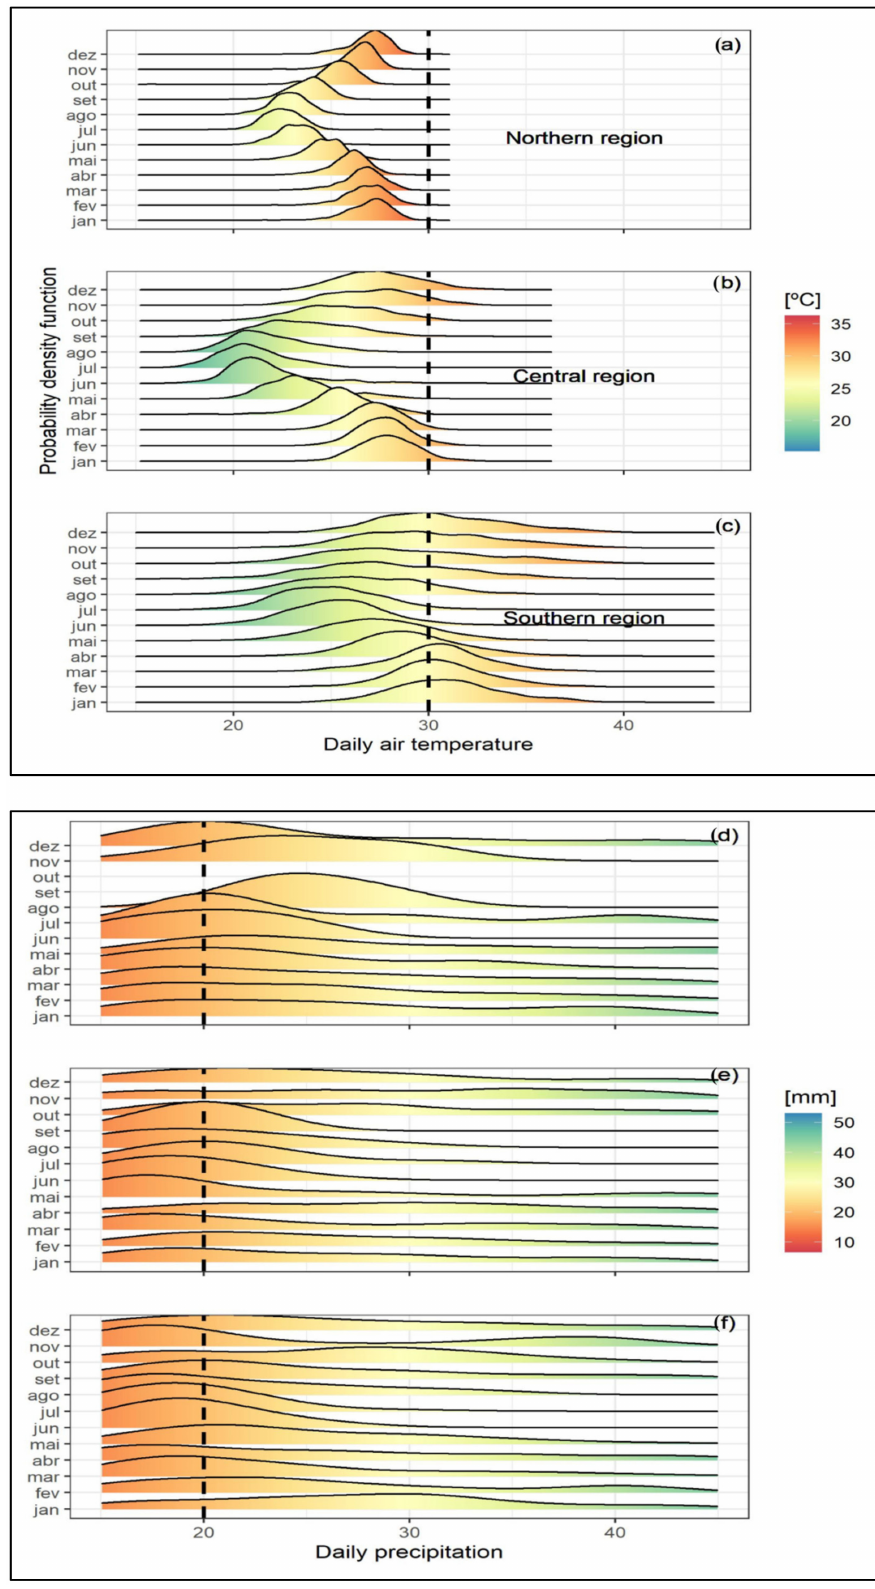
Figure 2. The probability density for the annual climatological cycle of air temperature and monthly precipitation in each region (( a , d ) for northern, ( b , e ) for central, and ( c , f ) for southern) of the study